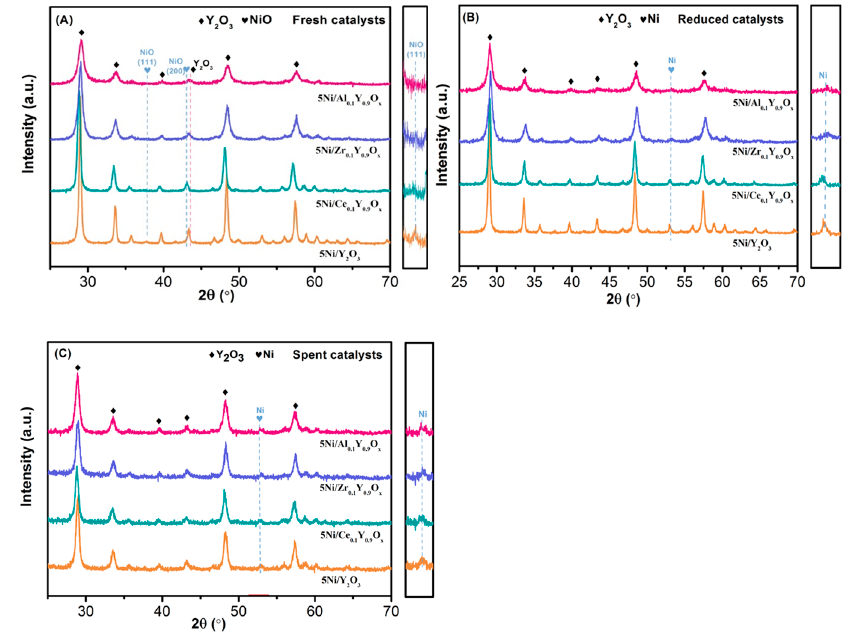
Figure 5. XRD of the ( A ) Fresh, ( B ) Reduced, and ( C ) Spent catalysts. Table 3. Surface areas and crystallite sizes of the catalysts before and after the Figure 5C demonstrates the XRD patterns of the catalysts after the 50 h stability test.